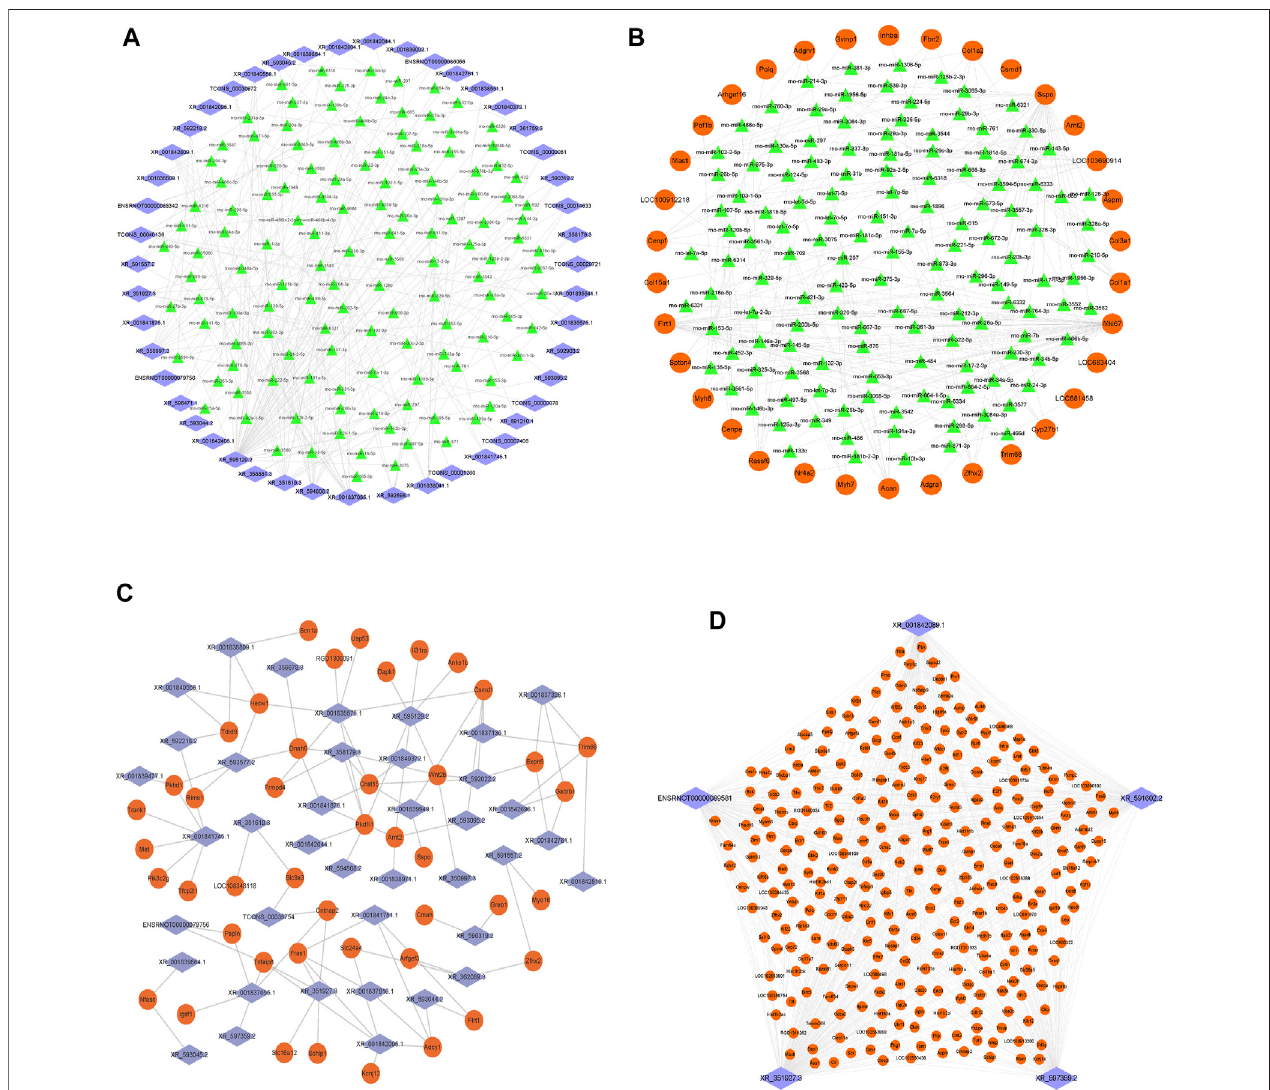
FIGURE 6 | Construction of the lncRNA – miRNA – mRNA network. (A) Network of the top 200 miRNA – lncRNA interactions. (B) Network of the top 200 miRNA – mRNA interactions. (C) Network of the top 100 lncRNA – mRNA of ceRNA interactions. (D) Top fi ve lncRNA XR_351927.3, ENSRNOT00000089581, XR_597359.2, XR_591602.2, and XR_001842089.1 connections with DE-mRNAs in the ceRNA network. The blue diamond represents lncRNAs, the green triangle represents miRNAs, and the orange circle represents